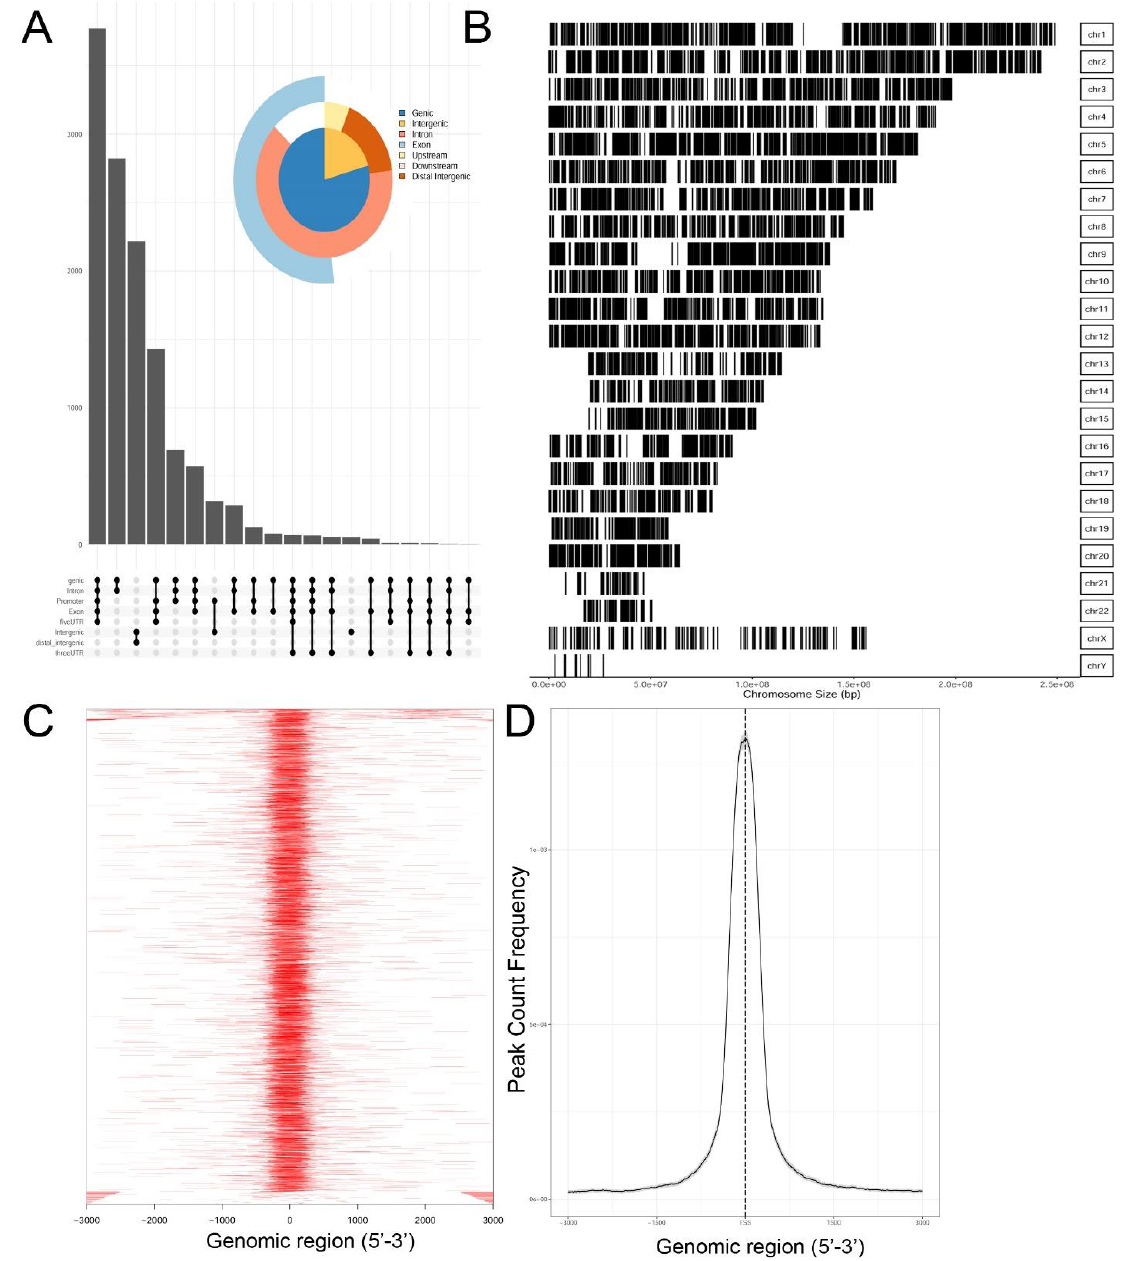
Figure 2. Occupancy analysis of control, human small airway epithelial cells (hSAECs). ( A ) “Upset” plot of genomic annotations of ATAC-Seq peaks. The upset plot provides information on correspondence of multiple peaks in a gene body. Note the most frequent pattern are peaks contain the promoter, 5′UTR, exon, intron, and 3′ UTR. Inset, pie chart of genomic region annotation. ( B ) Genome coverage of open chromatin domains. Shown is a linear representation of open peaks for each chromosome (labeled at right). ( C ) Tagged heat map of open chromatin domains relative to the 5′ regulatory region from −3000 nt to +3000 nt. Each red bar represents the length of open chromatin domain on a gene. ( D ) Distribution of peaks relative to the transcription start site (TSS). Note the symmetric distribution over the TSS.